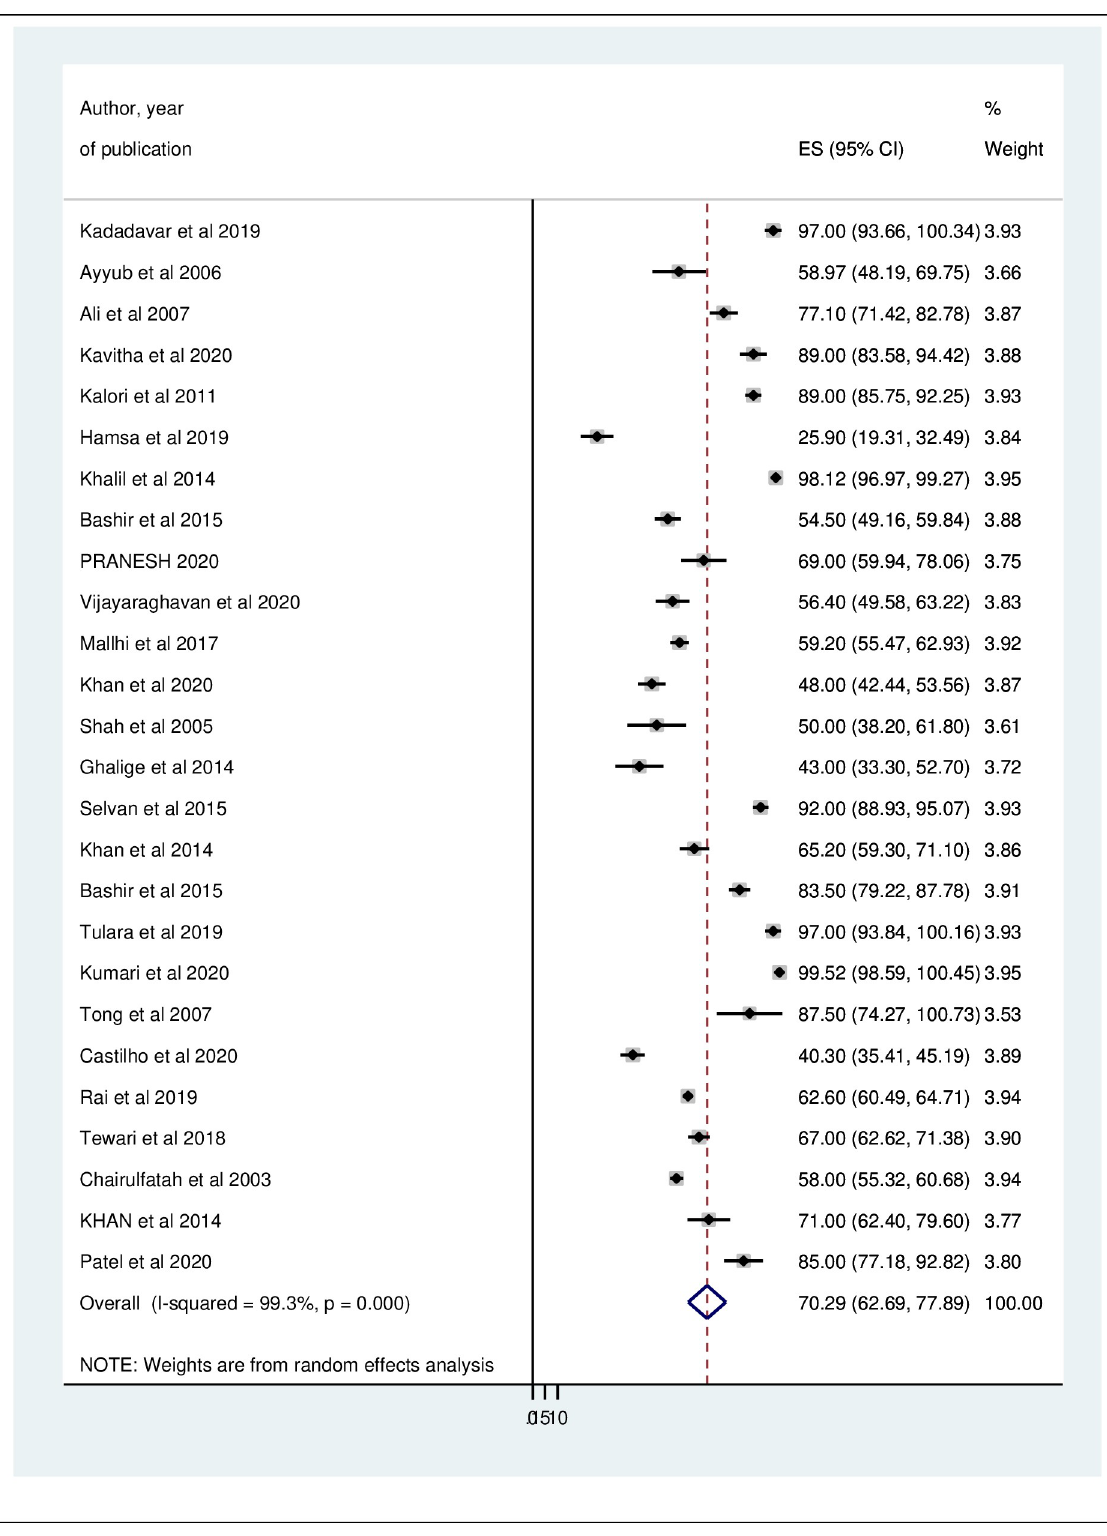
PLOS NeglectedTropical Diseases | https://doi.org/10.1371/journal.pntd.0009666 August 18,